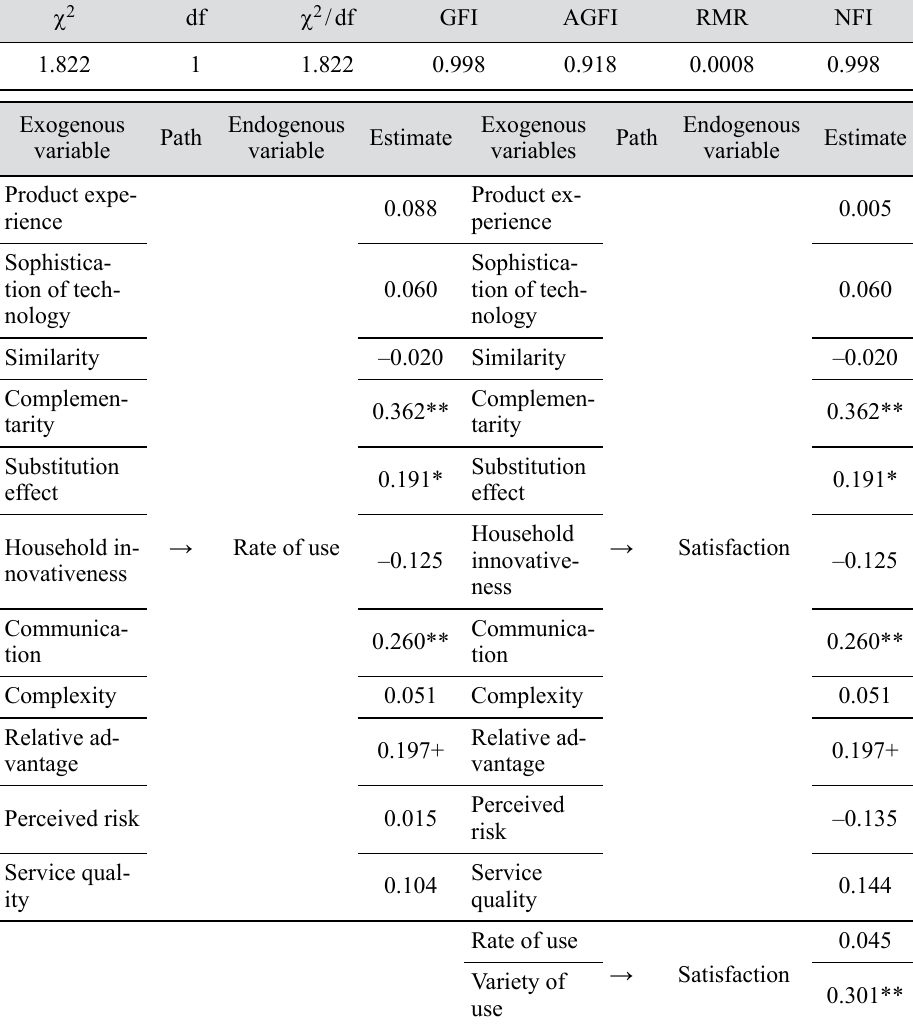
Table 4. Results of structural analysis of the use-diffusion model on